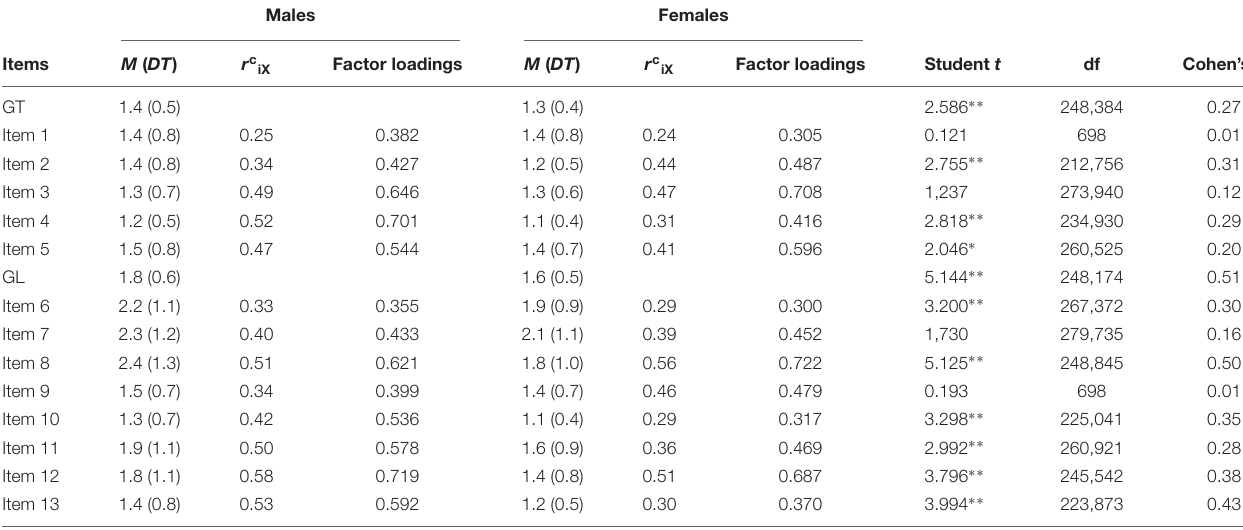
TABLE 1 | Descriptive statistics and factor loadings (CFA two-factor model) and mean scores comparison of SRQ for males ( n = 176) and females ( n = 524). Males Females